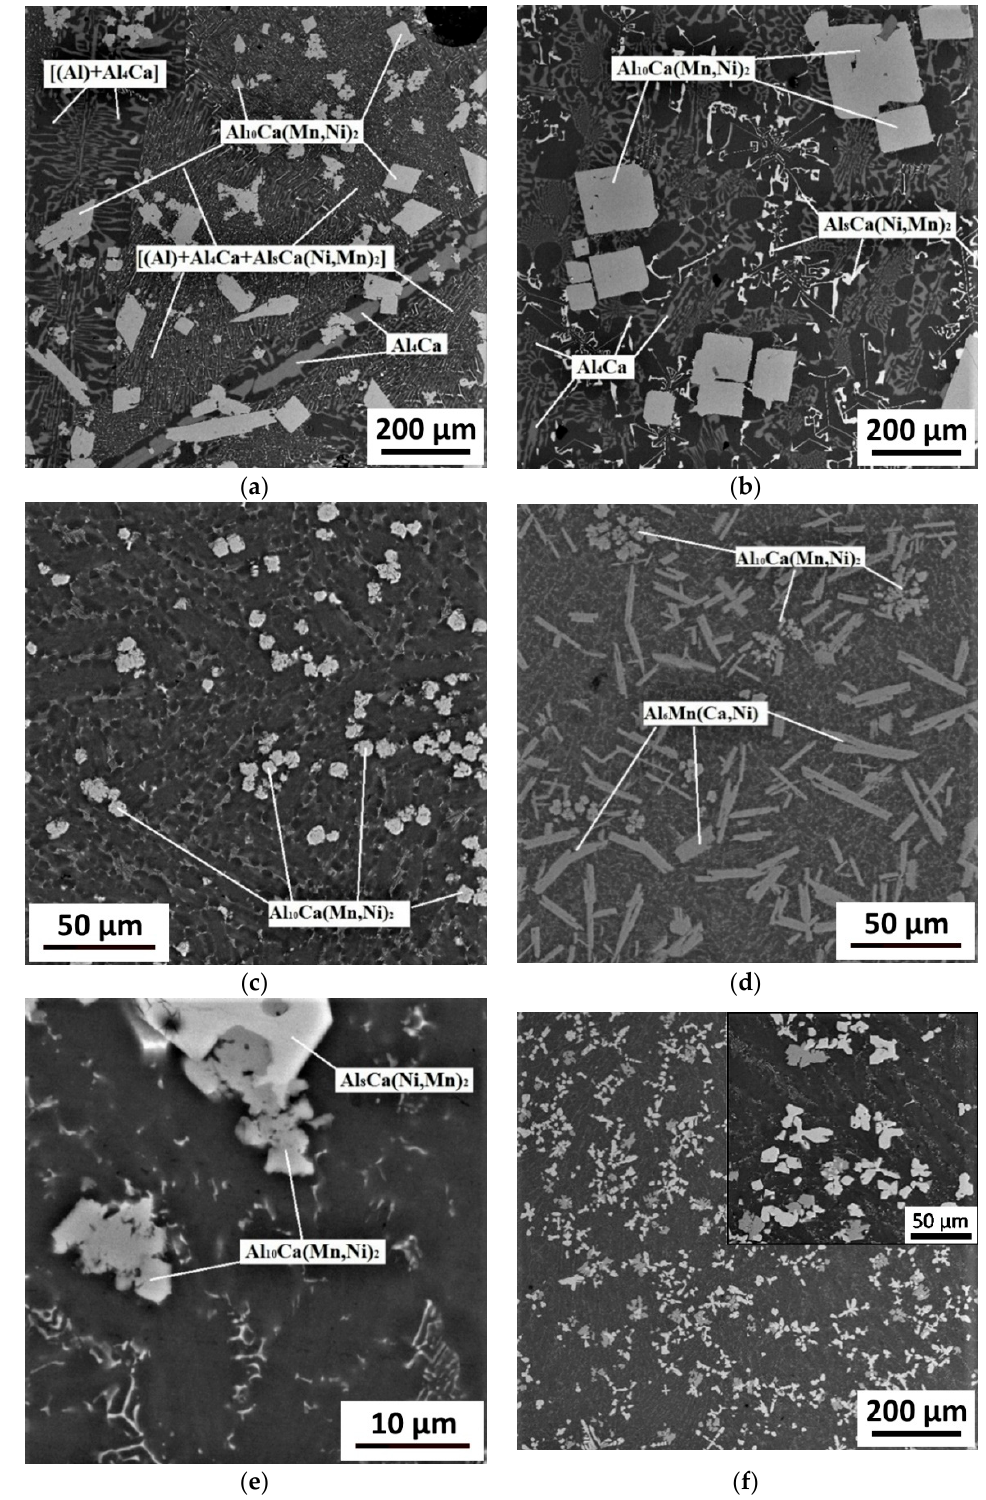
Figure 7. SEM images showing the primary crystals appeared in the as-cast Al-Ca-Mn-Ni alloys: ( a ) Al-8Ca-2Mn-1Ni (slow cooled); ( b ) Al-6Ca-3Mn-2Ni (slow cooled); ( c ) Al-8Ca-2Mn-1Ni (10K/s); ( d ) Al-6Ca-3Mn-2Ni (10K/s); ( e ) Al-8Ca-2Mn-2Ni (slow cooled); ( f ) Al-8Ca-2Mn-4Ni (10K/s) . The structure of the Al-8Ca-2Mn-1Ni alloy formed at a cooling rate of 10 K/s (Figure 7c) represents a perfect natural composite and therein equiaxed small (no more than 10-